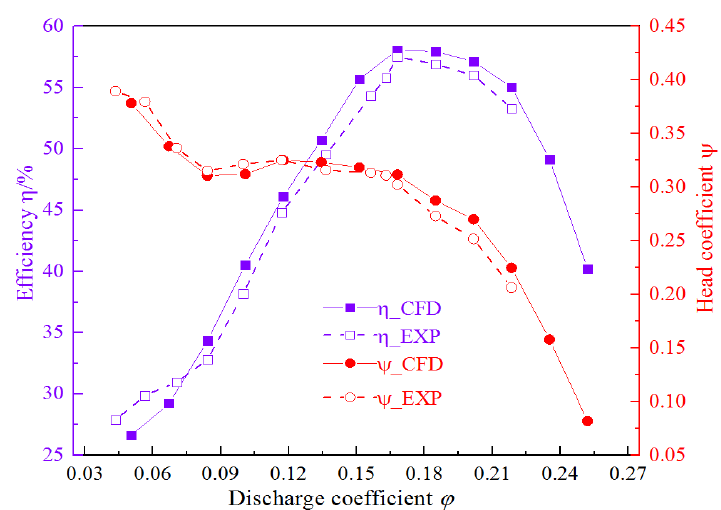
Figure 4. Comparison of performance results between simulation and experiment ( IGVF = 0%). CFD: computational fluid dynamics; EXP: experiment. Table 6. Values of head with different IGVF s for simulation and experiment ( Q = 50 m 3 /h).